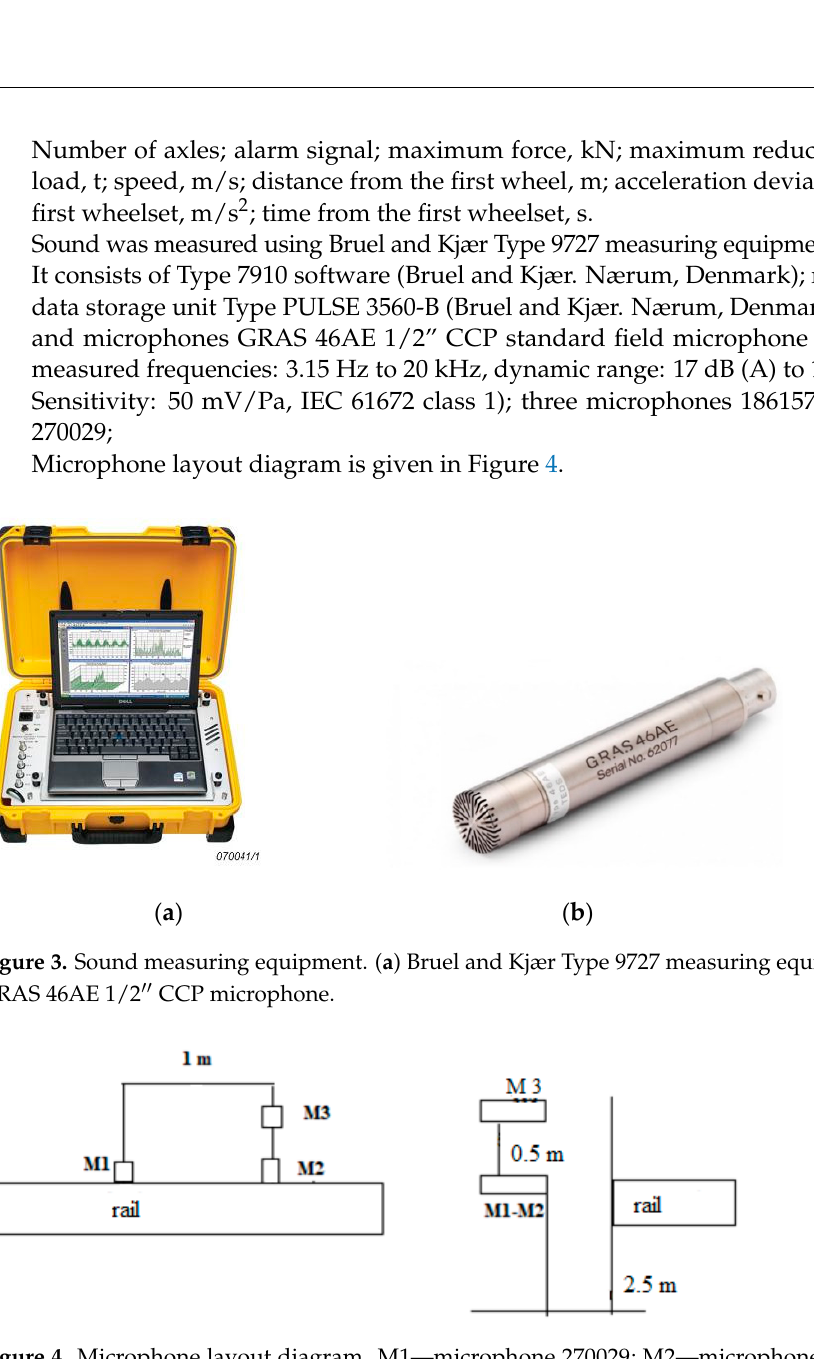
Figure 4. Microphone layout diagram. M1—microphone 270029; M2—microphone 190590; M3— microphone 186157